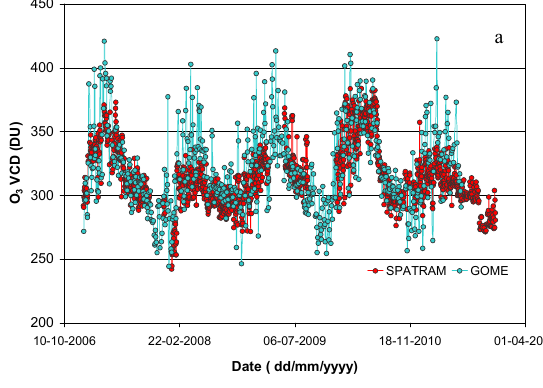
Figure 3. a) Time series of the O 3 VCD obtained with the SPATRAM equipment installed at Évora Observatory during 2007-2011, and the O 3 data from the SCIAMACHY instrument aboard the ENVISAT satellite. b) Scatter plot of the O 3 data from the SCIAMACHY instrument (TOSOMI product) versus SPATRAM data retrieved at Évora Observatory for the same period. Figure 4 shows the comparison of SPATRAM and GOME